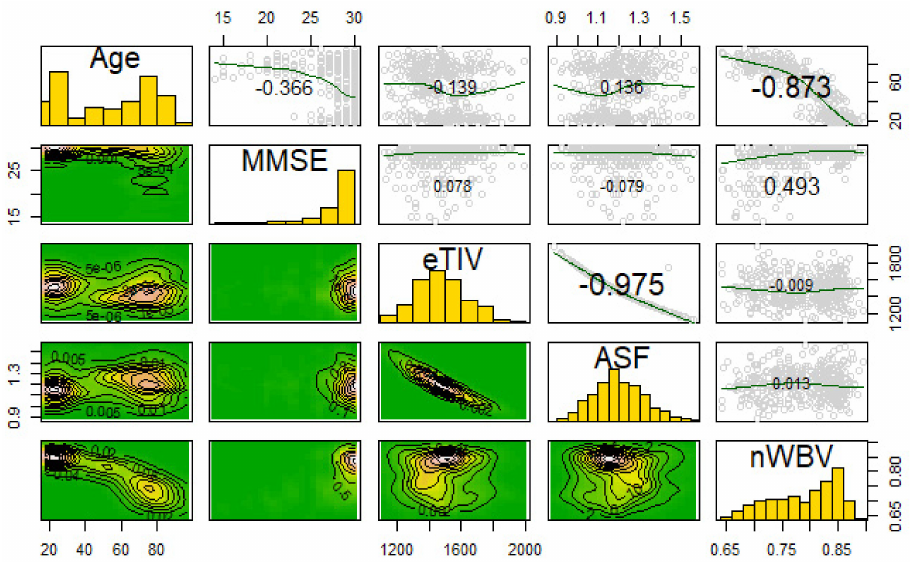
Figure 5. Correlation plots of all quantitative variables eTIV—estimated Total Intracranial Volume; ASF - Atlas Scaling Factor; nWBV—normalized Whole-Brain